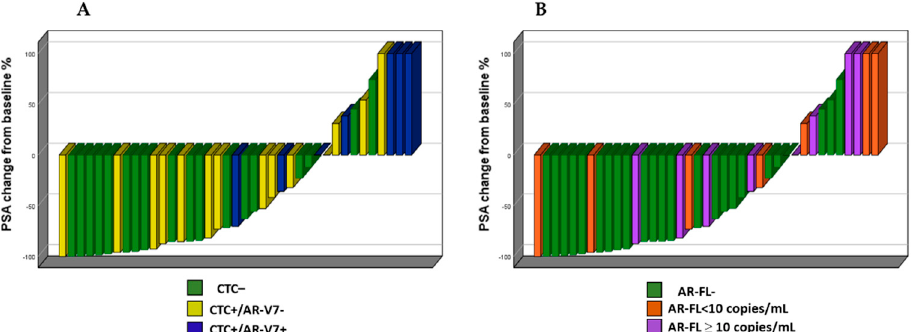
Figure 1. Best prostate-specific antigen (PSA) response according to circulating tumor cells/androgen receptor splice variant 7 (CTC/AR-V7) status ( A ) and number of androgen receptor full-length (AR-FL) copies ( B ).